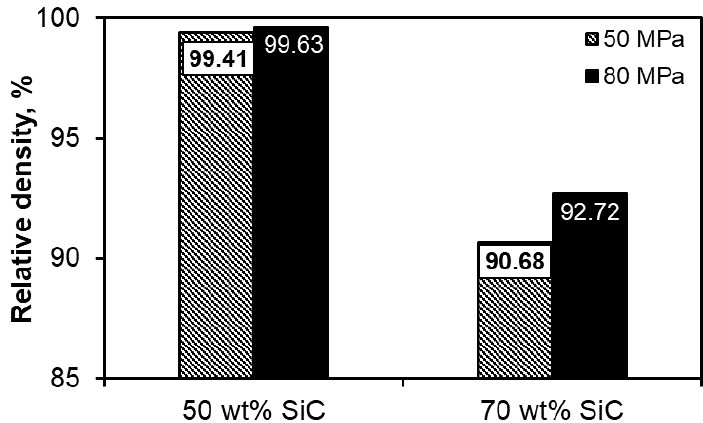
Figure 3. Relative densities ascertained by Archimedes method.